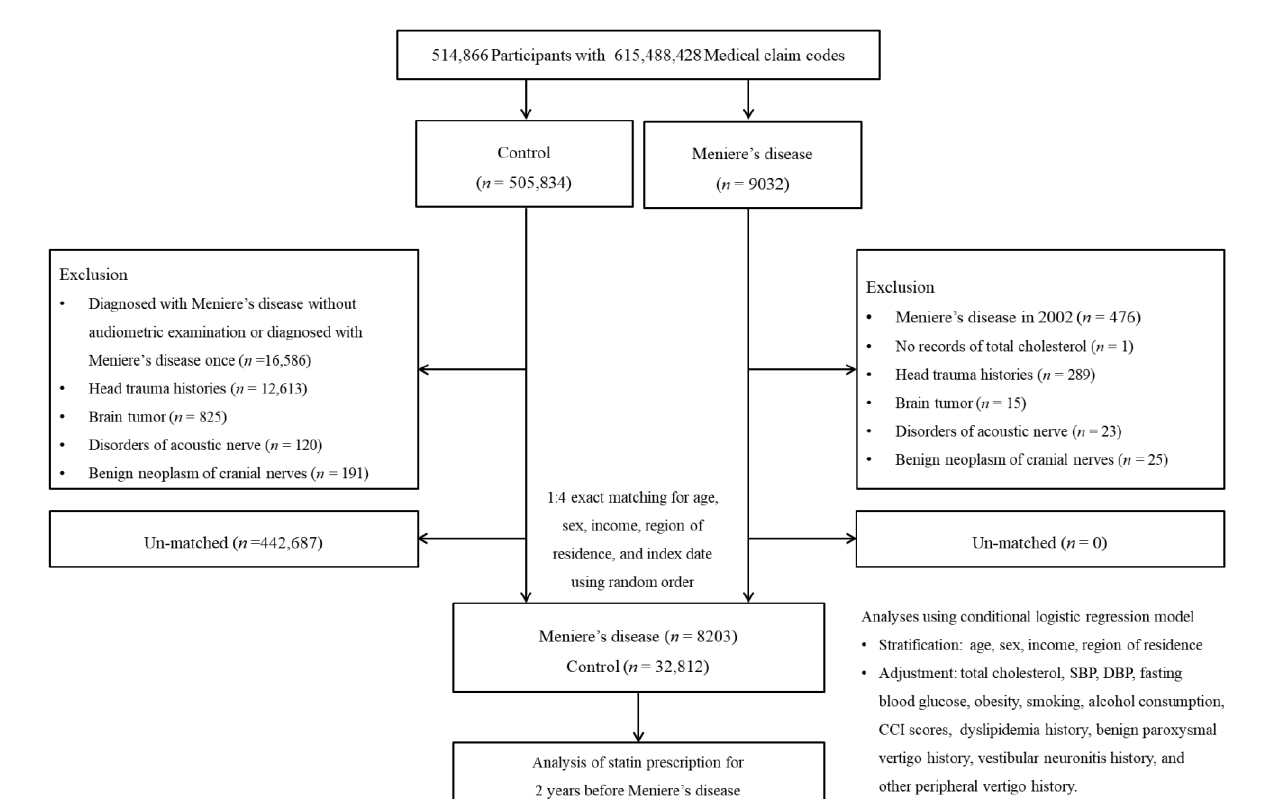
Figure 1. A schematic illustration of the participant selection process that was used in the present study. Of a total of 514,866 participants, 7734 Meniere’s disease participants were matched with 30,936 comparison participants for age, sex, economic level, and region of residence.